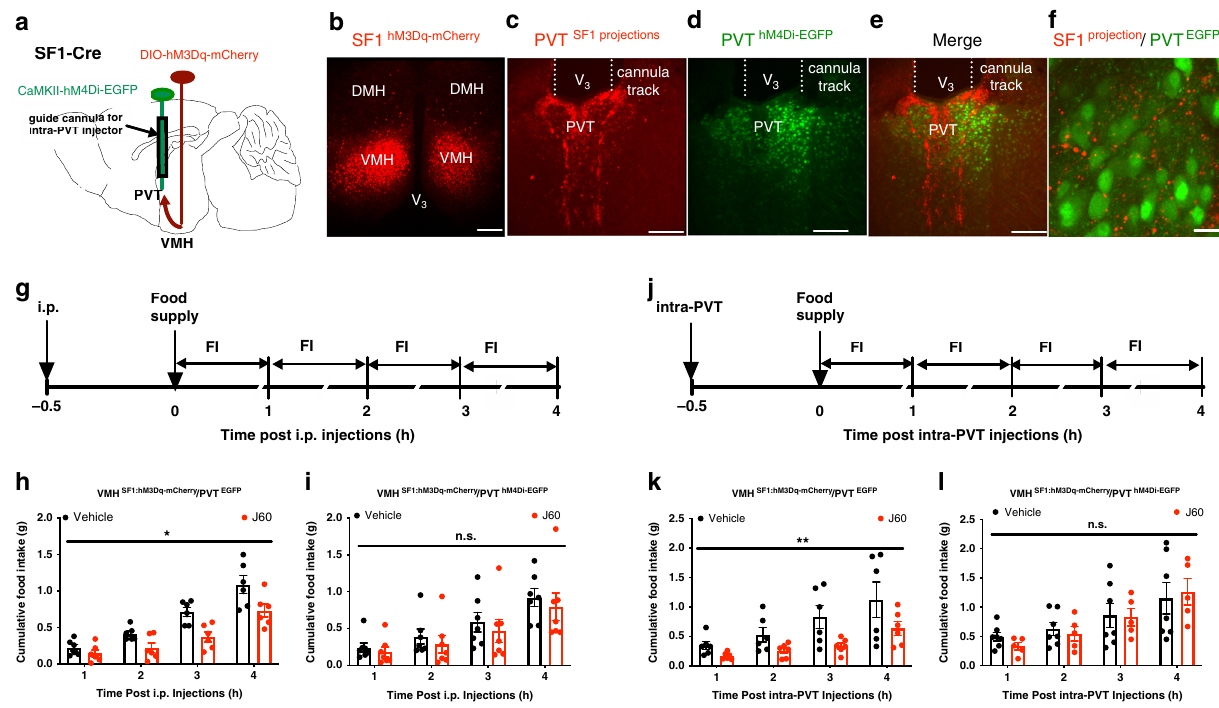
Fig. 6 Chemogenetic inactivation of PVT neurons blocks the SF1 suppression of food intake. a Schematic illustration of co-transductions of VMH SF1 neurons with hM3Dq and PVT neurons with hM4Di and a guide cannula for intra-PVT injections. b – f Representative confocal images of b hM3Dq-mCherry transduced SF1 neurons in the VMH, c SF1 projections in the PVT, d hM4Di-EGFP-transduced neurons and a cannula track in the PVT, and e , f merged SF1- mCherry projections and EGFP-transduced PVT neurons. g – i Simultaneous inactivation of PVT neurons with J60 administration via i.p. injections diminished SF1 suppression of feeding: g experimental protocol for J60 administration via i.p. injections and the amount of food intake calculated at the indicated time points; h , i group data of food intake measured in the h SF1 hM3Dq and PVT EGFP-transduced mice ( n = 6 per group; p = 0.0174), and i